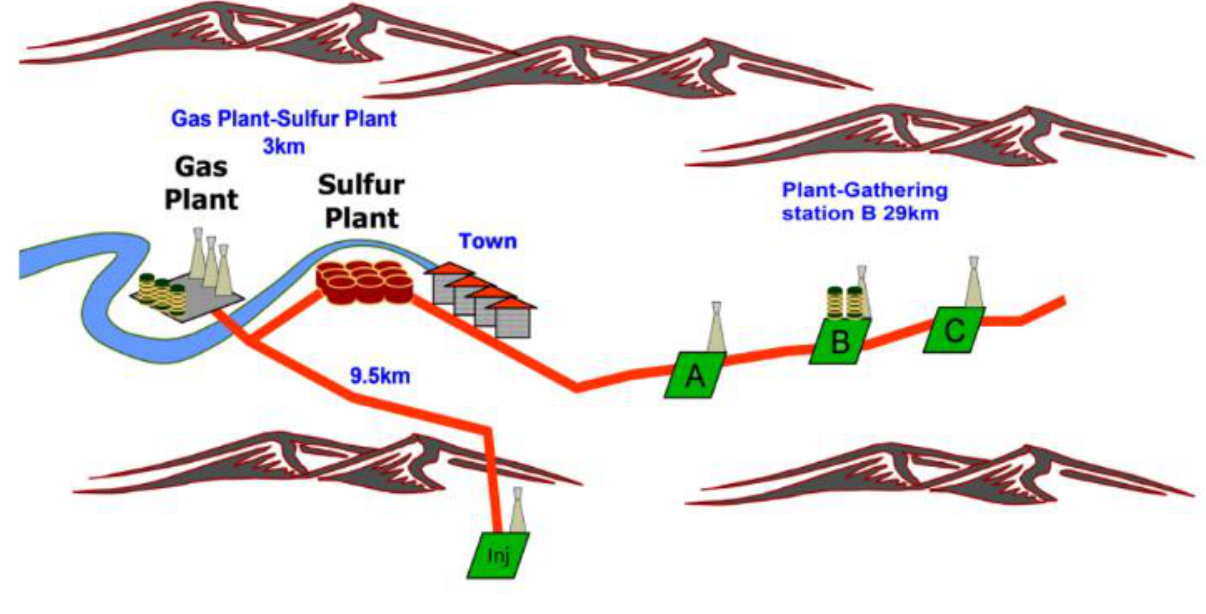
Figure 1—Sour gas development